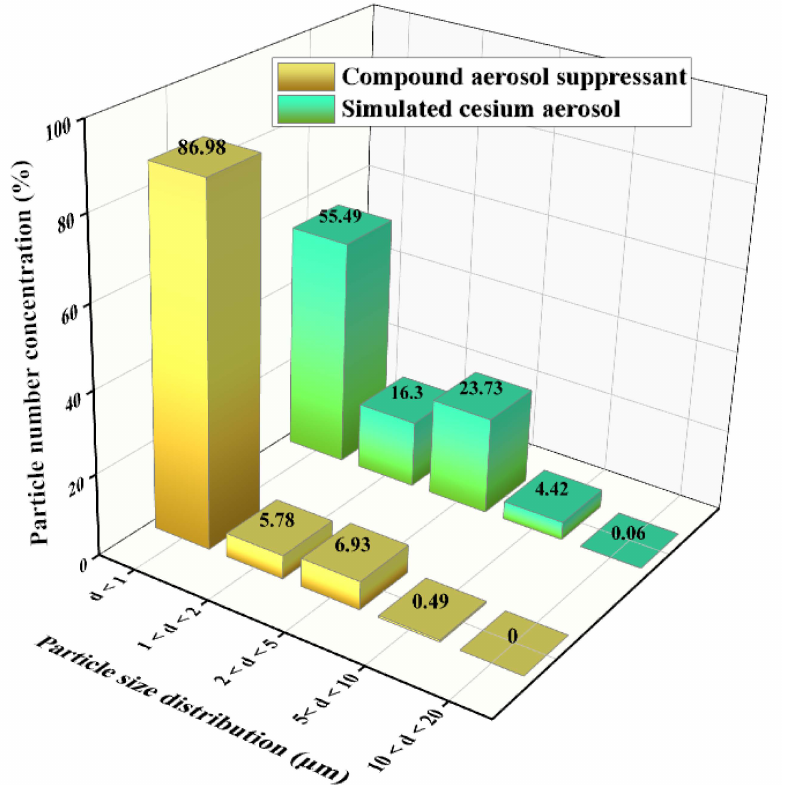
Figure 8. Particle size distribution of the simulated cesium aerosol droplets and compound- suppressant droplets in the sedimentation